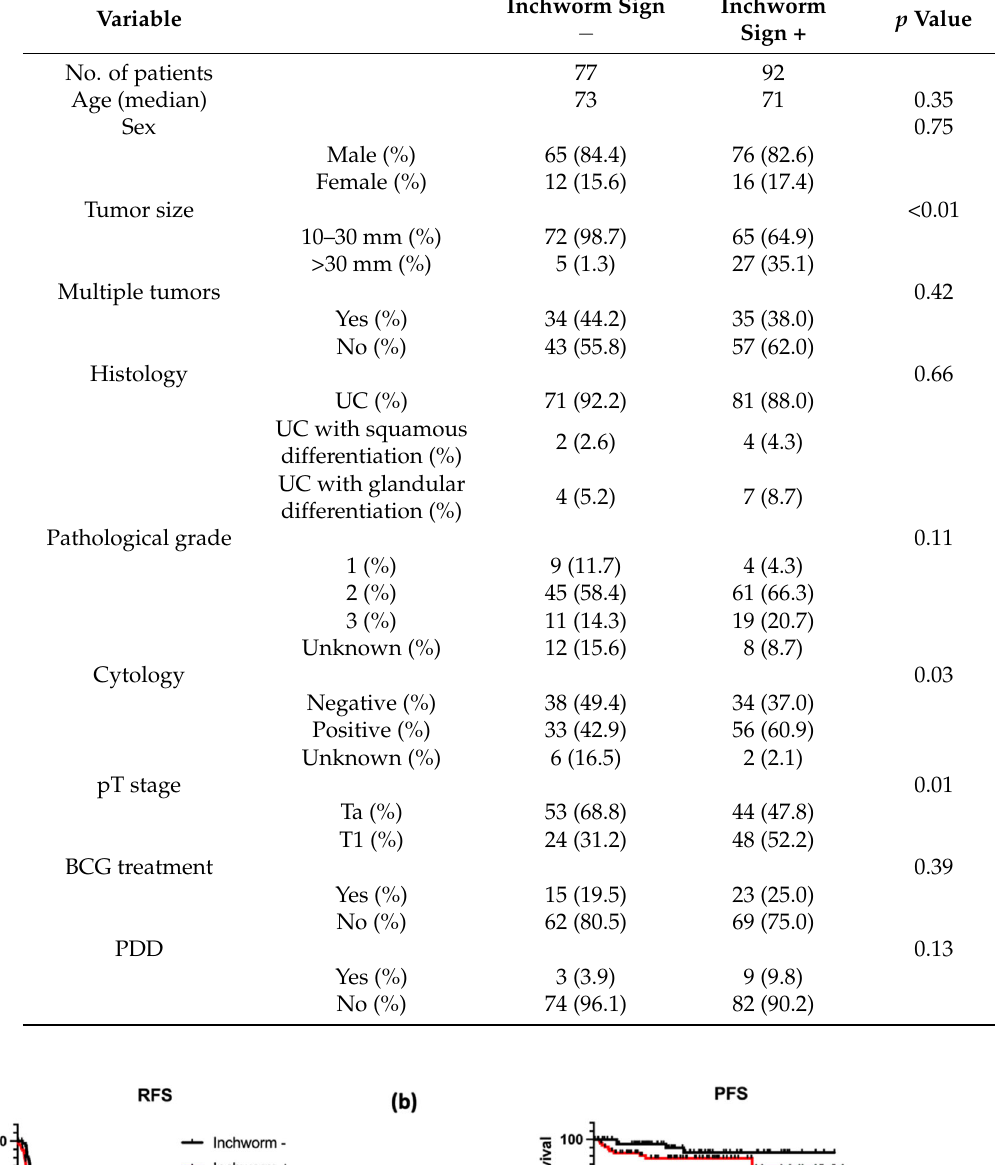
Table 3. Characteristics of patients with NMIBC.